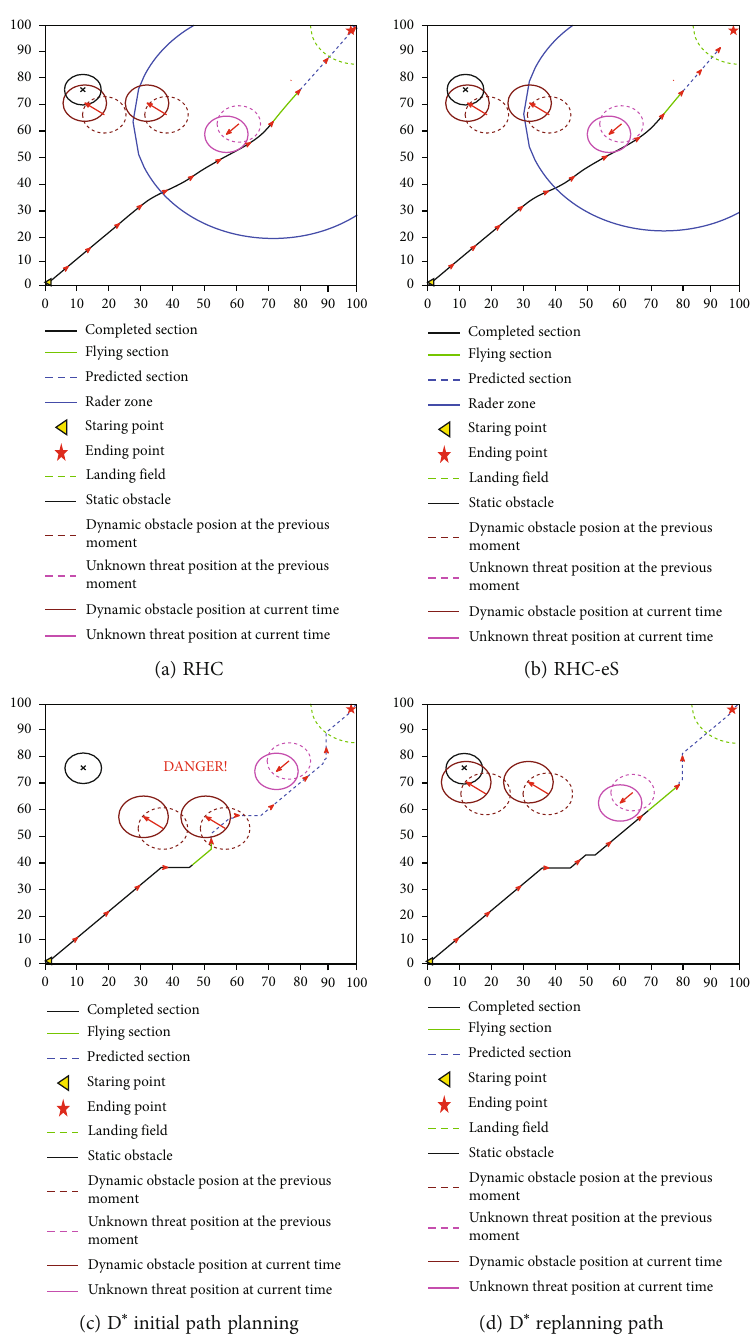
Figure 8: Environmental case 4 path planning